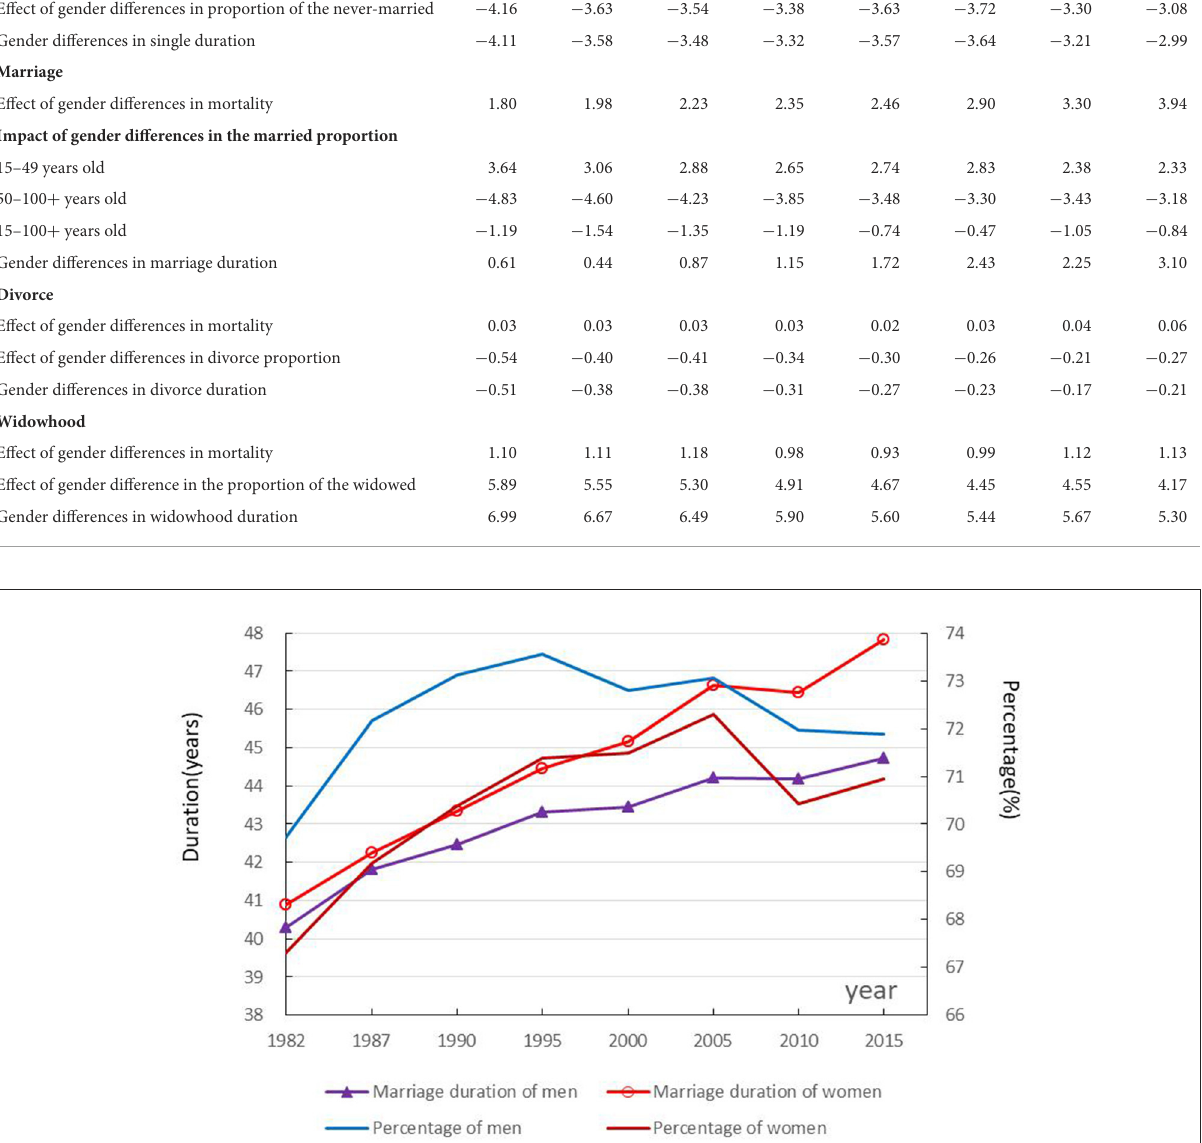
FIGURE2 Trends in marriage duration and proportion among 15-year-olds.